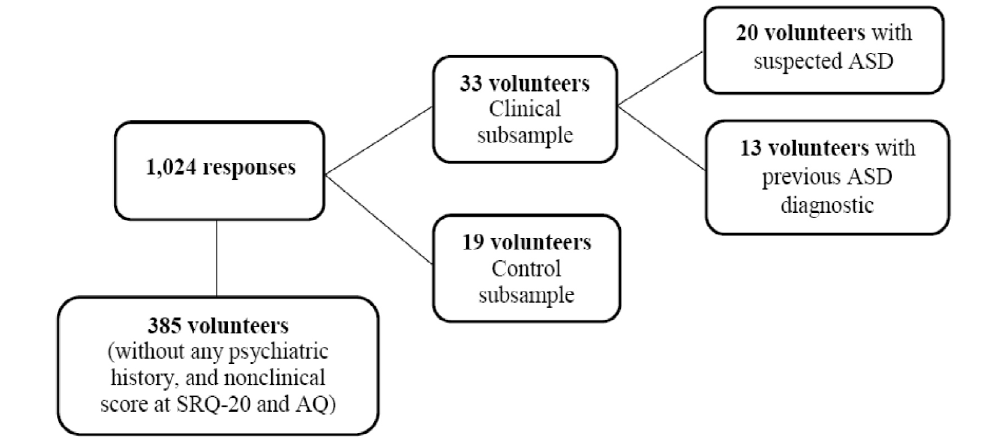
ASD: Autism Spectrum Disorder; SRQ-20: Self-Reporting Questionnaire-20; AQ: Autism Spectrum Figure 1. Diagram of the study design.